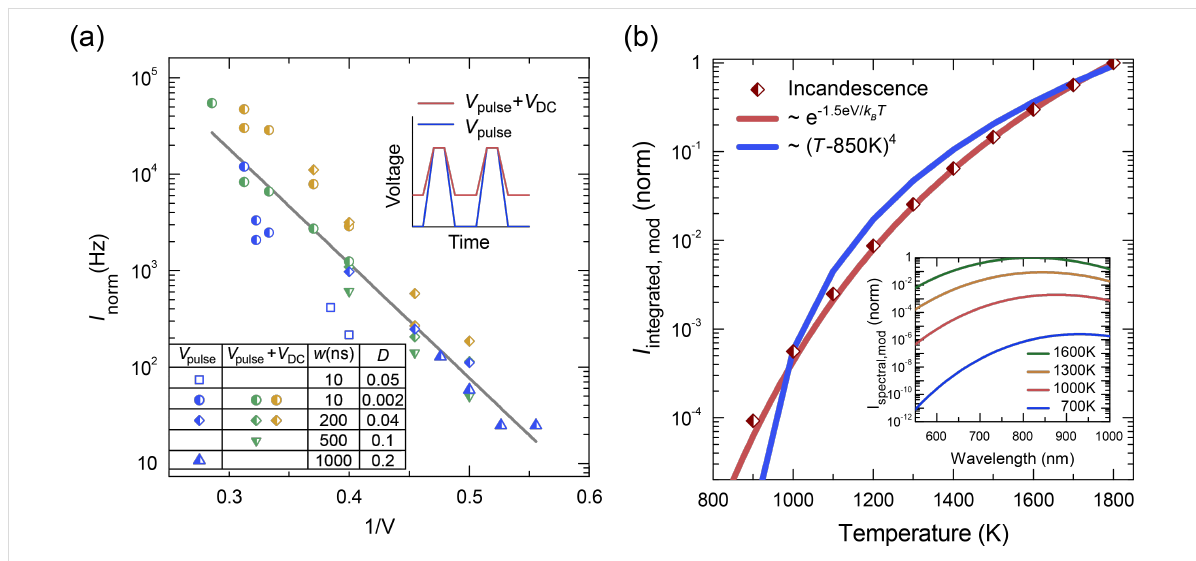
Figure 2: (a) Normalized total intensity I norm versus 1/ V under variation of electrical pulse width, w , and duty cycle, D . The full line is a fit to the data. Data acquired with an additional offset voltage V DC = 1.5 V is labeled with green and yellow symbols, data acquired without offset is shown as blue symbols. The inset schematically illustrates two biasing schemes. All measurements refer to light propagating along the surface normal collected with the free-space setup. (b) Simulation of the temperature-dependent total intensity of the incandescent light collected with a CCD camera I integrated,mod ( T ) (red symbols), compared with exponential (red line) and power law (blue line) fits. Inset: Simulated spectra I spectral,mod ( λ , T ) of incan- descent light sources emitting at the indicated temperatures. The shape of the spectra deviates from the Planck curve I therm ( λ , T ) because of the spec- tral sensitivity of the detector S ( λ